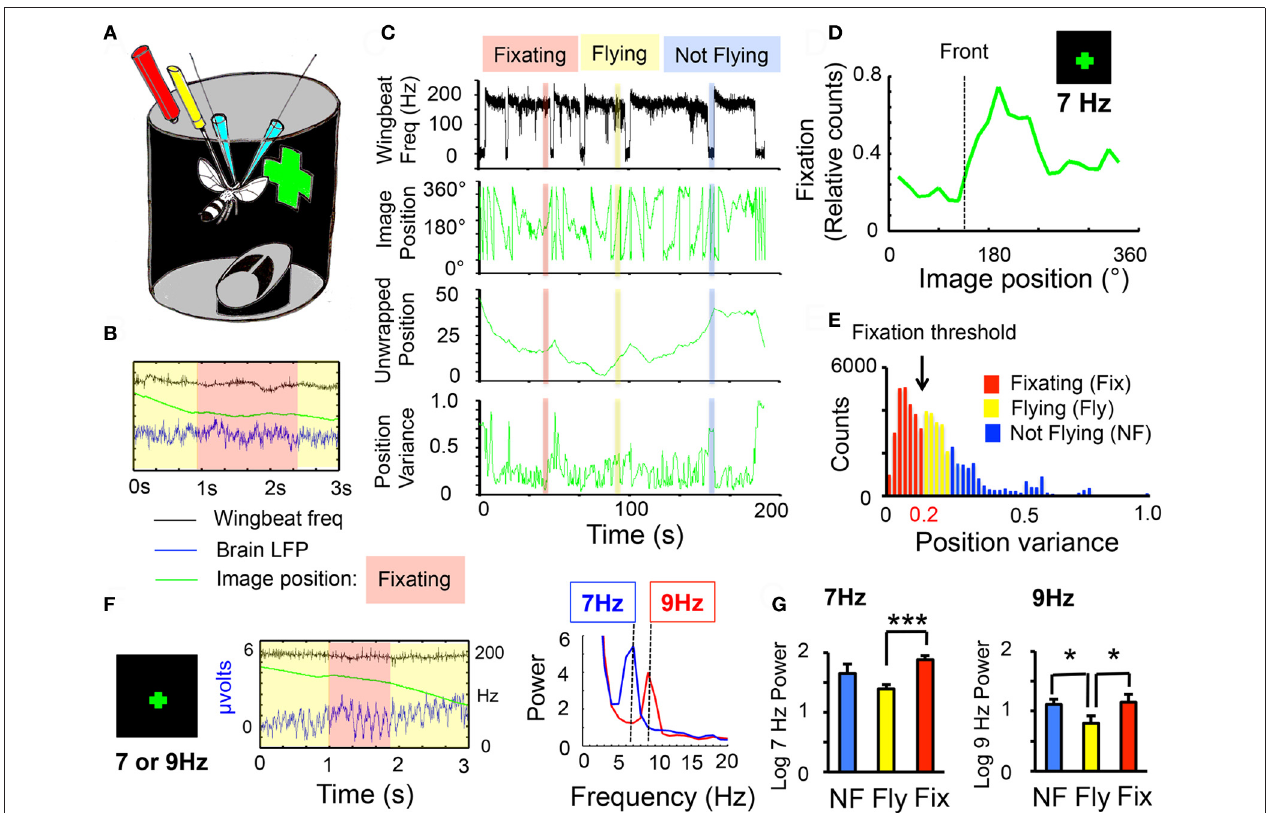
together at 7Hz. Image fixation is indicated by increased duration (relative time) in one part of the visual field, usually close to front (dotted line). Data are averaged from 6 wild-type male flies. (E) Fixation behavior was determined empirically per fly from the position variance statistics (see “Materials and Methods”). (F) LFP responses to a 7 or 9Hz flickering cross. Middle panel: LFP (blue trace) recorded during fixation of a 9Hz flickering cross. Green line: angular position of image (same axes as in C, second panel down); black trace: wing-beat frequency indicating flight. Fixation time is indicated by the red rectangle. Right panel: sample spectral analysis (see “Materials and Methods”) for a 7Hz (blue) or a 9Hz (red) cross during behavioral fixation. (G) Normalized 7 or 9Hz power (log score ± SEM) for the three behavioral states (NF, blue, not flying; Fly, yellow, flight without fixation; Fix, red, flight with fixation, n = 6 male wild-type flies; ∗ P < 0 . 05, ∗∗∗ P < 0 . 001 by t- test). All responses were significantly greater than zero ( = the 8Hz denominator, indicating the presence of a frequency tag, P < 0 .